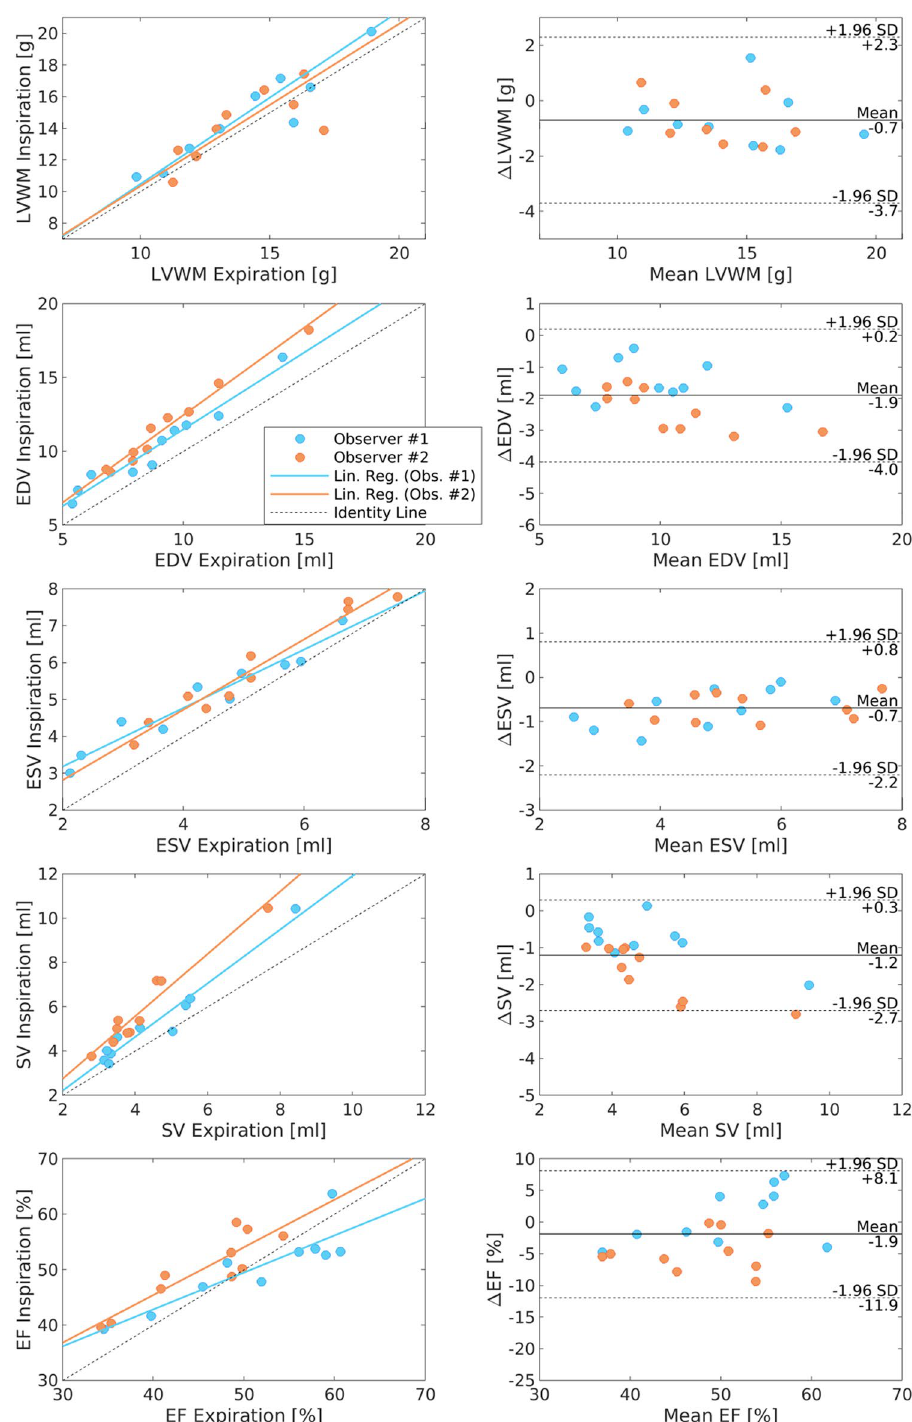
Figure 4. Comparison of inspiratory and expiratory ventricular function. Correlation and Bland–Altman plots of LVWM, EDV, ESV and EF for inspiration and expiration obtained by RT-MRI of the first study time point (test). Volumetric parameters (EDV, ESV and SV) were increased by at least 20% during inspiration compared to expiration. Additionally, a slight increase in EF was observed during inspiration. Nevertheless, a strong correlation between the two respiration phases exists. LVWM: Left Ventricular Wall Mass; EDV: End-Diastolic Volume; ESV: End-Systolic Volume; SV: Stroke Volume; EF: Ejection